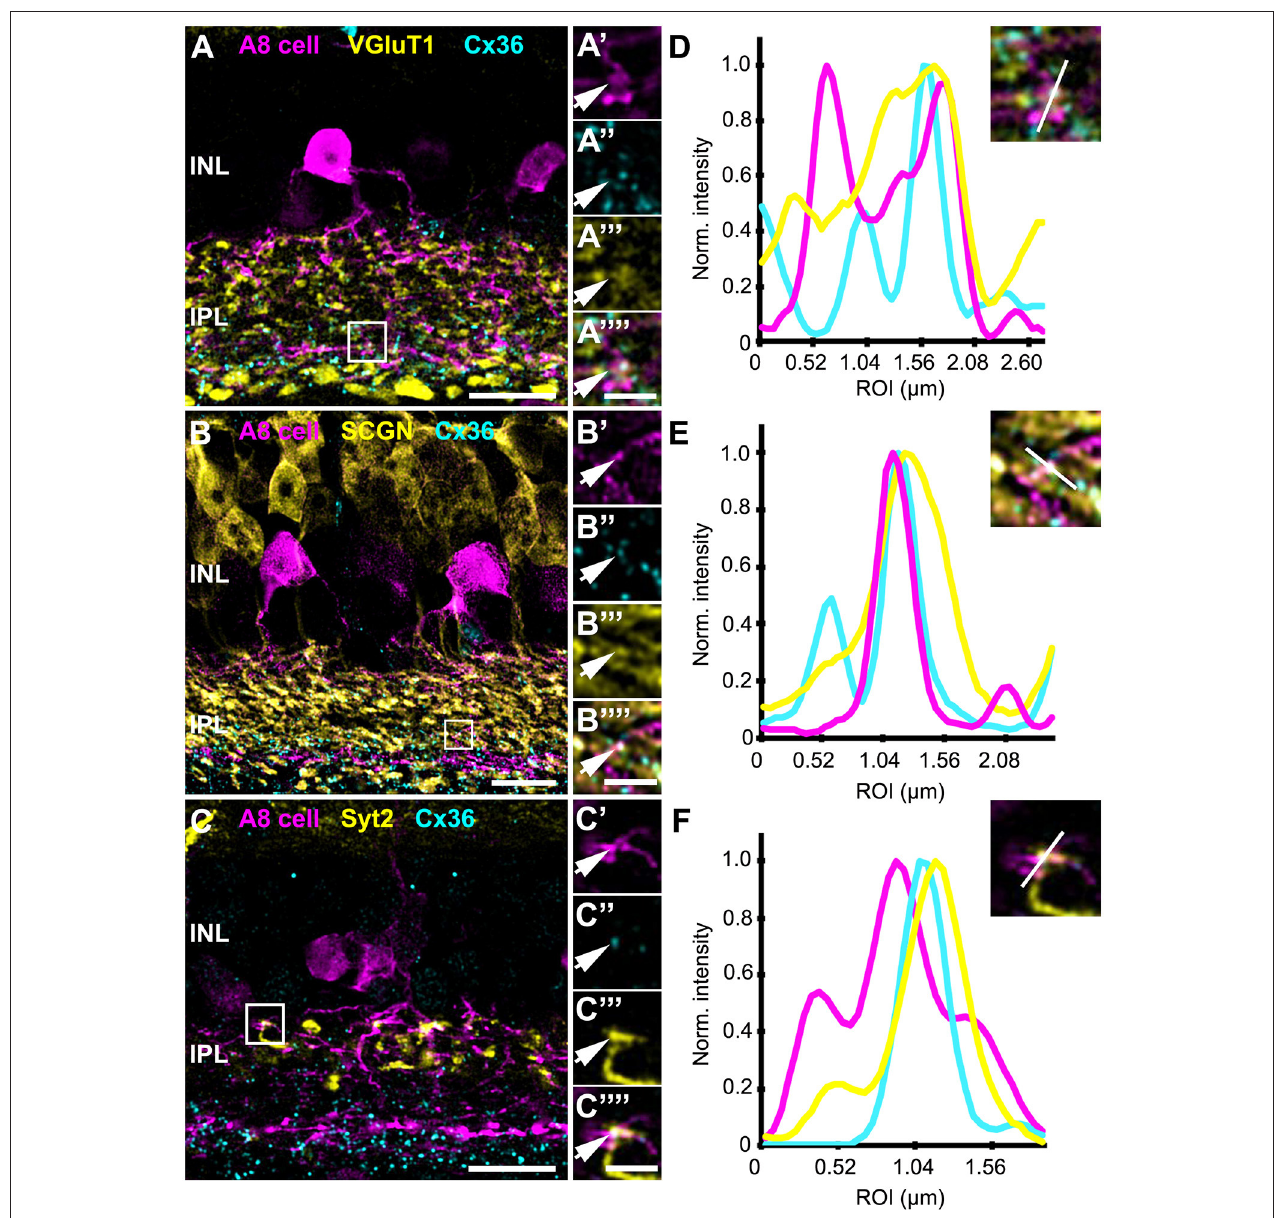
FIGURE 5 | Co-localization of A8 gap junctions with bipolar cell terminals in vertical sections. (A–C) Single retinal slices of Ier5-EGFP (A8 cell) mouse stained with Cx36 and bipolar cell markers: VGluT1 (A) , secretagogin [ (B) , SCGN], and synaptotagmin-2 [ (C) , Syt2]. Square white boxes in (A–C) are the selected ROIs shown in (A’–C””) . Arrows denote co-localization of all the three channels which is also represented in the normalized intensity plots (D–F) . (D–F) Intensity plot for three channels, corresponding to (A–C) . The respective inset represents the single scan overlay of the three channels. The plot denotes normalized pixel intensity of three channels in y-axis, and the x-axis represents the relative distance of peak intensities of the three individual channels. Scale bar: (A–C) , 10 µ m; (A’–C””) , 2.5 µ m.